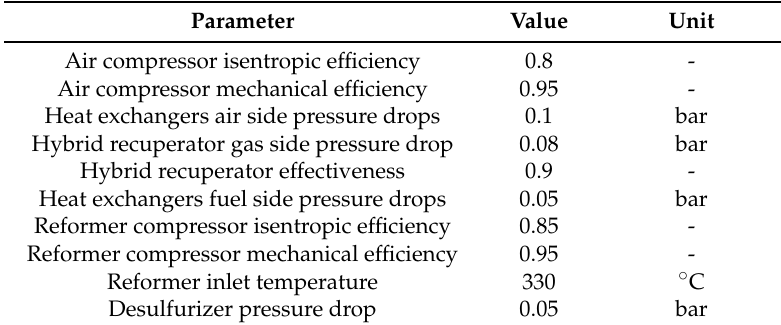
Table 5. System operating input parameters.